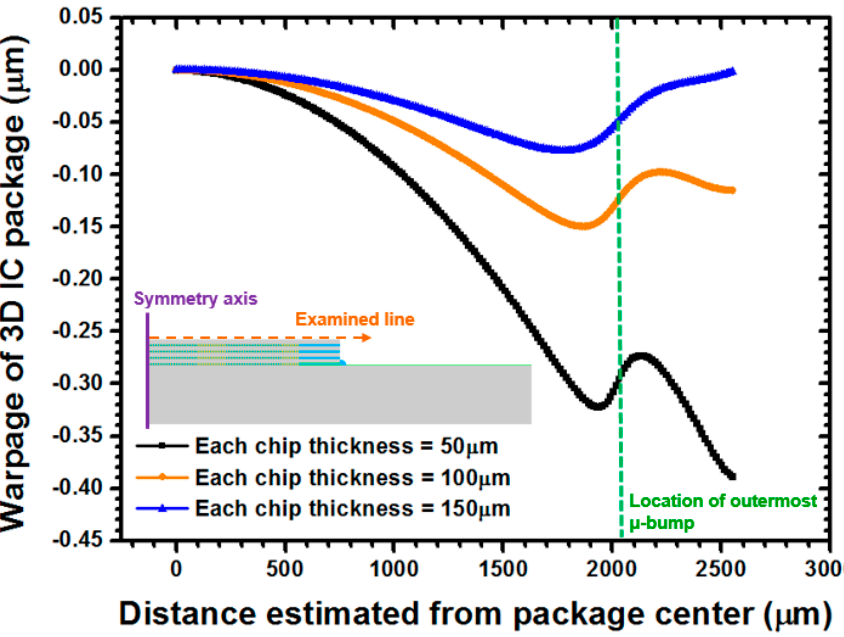
Figure 9. Estimated warpage of the 3D-IC package under WLUF, after the implementation of a stable temperature cycling load, given different stacked chip thicknesses (examined at 25 °C).